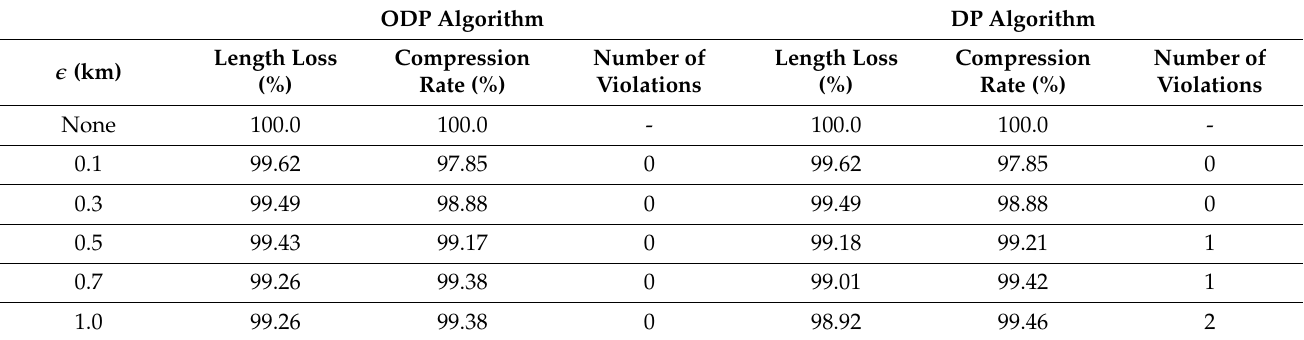
Table 2. Comparison of the results obtained using the ODP and DP algorithms for trajectory 4. ODP Algorithm DP